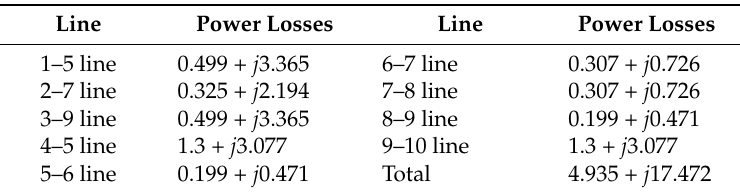
Table 3. The power losses of